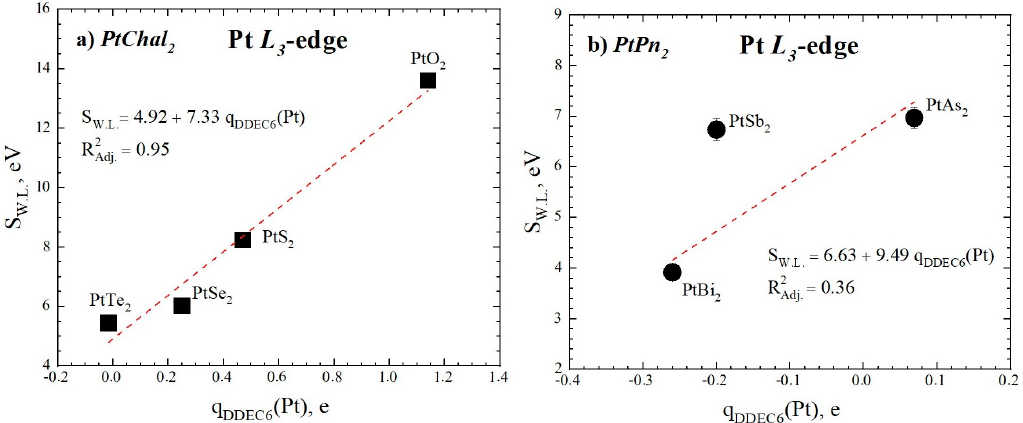
Figure 6. The correlation between the white line area (S W.L. ) of Pt L 3 -edge spectra and the Pt DDEC6 charge. ( a ) PtChal 2 and ( b ) PtPn 2 groups.